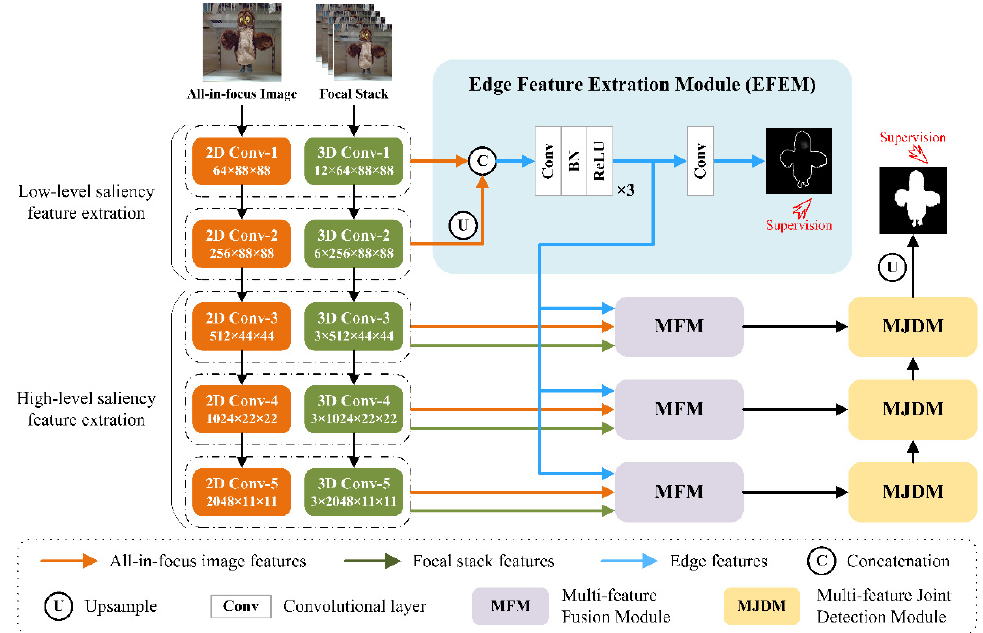
Figure 1. The overall structure of our proposed network.